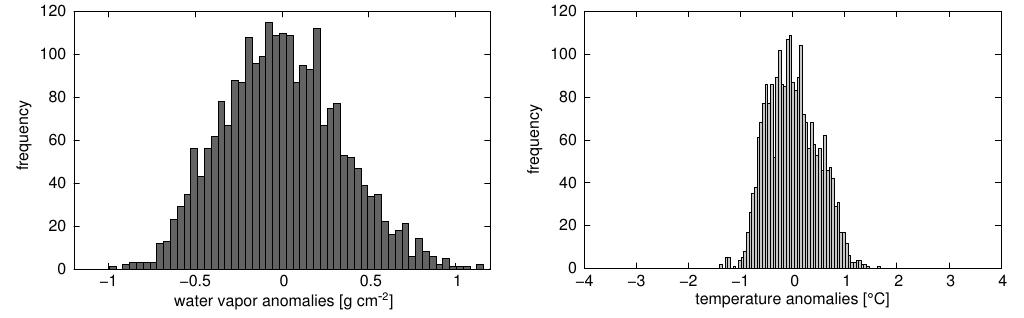
Fig. 4. Frequency distributions of 2400 water vapour and temperature anomalies from the islands of Hawaii. Similarly to Fig. 3 the anomalies have been derived from monthly mean data, where we removed the trend and the seasonal components.